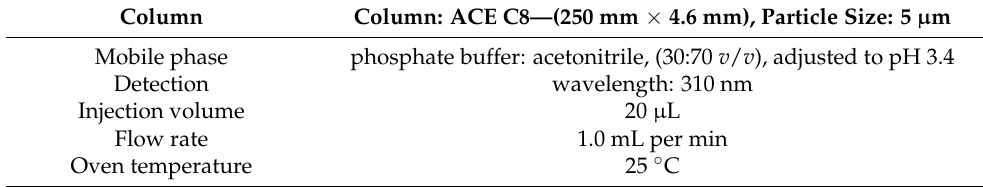
Table 2. Chromatographic conditions were used in the analysis.